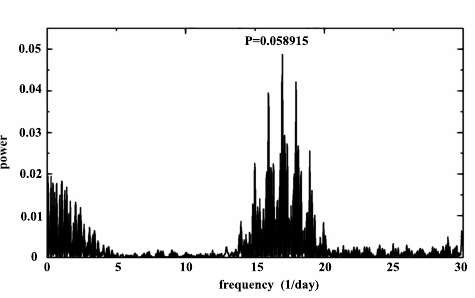
Figure 6: The power spectrum of J1502, calculated for all 6 nights of our